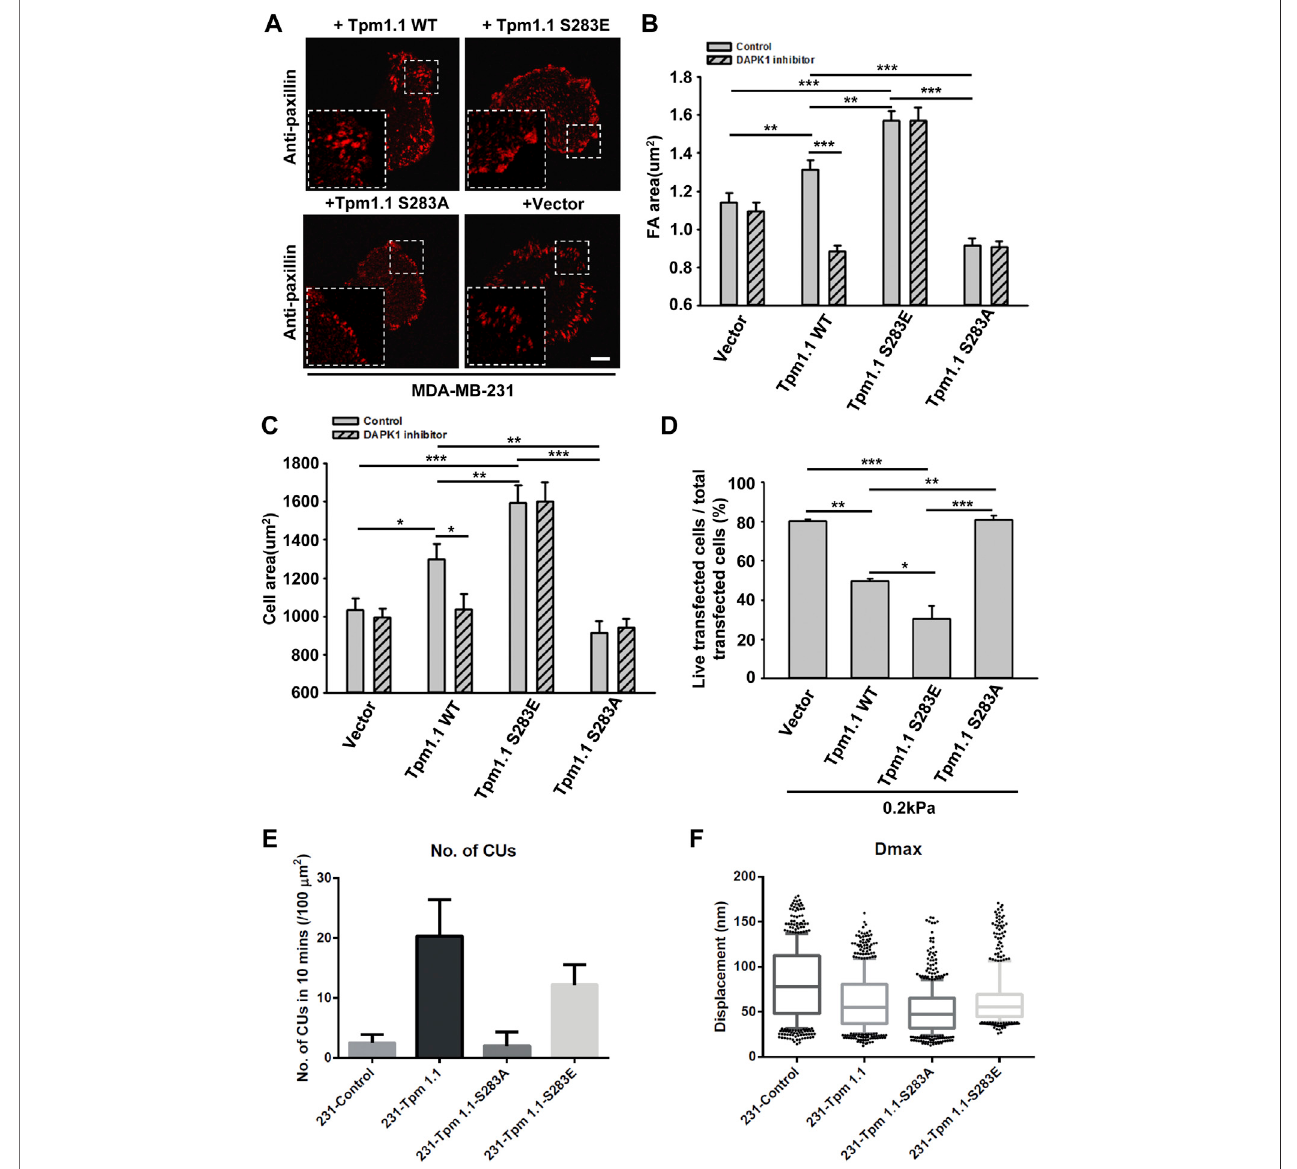
FIGURE 4 | The phosphorylation of Tpm1 by DAPK1 is important for adhesion formation but facilitates anoikis on soft substrates. MDA-MB-231 cells were transfected with Emerald-Tpm1.1 WT, Emerald-Tpm1.1 S283E (phosphomimetic mutant), Emerald-Tpm1.1 S283A (non-phosphorylated mutant), or control vector. Cells were spreading on fi bronectin-coated glass dishes with/without DAPK1 inhibitor for 30 min, followed by anti-paxillin/AlexaFluor 555 immunostaining. (A) Micrographs show the distribution of paxillin. Scale bar: 10 μ m. (B) Quanti fi cation of the adhesion sizes (n > 400 adhesions from > 10 cells in each case, mean ± SEM), ** p < 0.01, *** p < 0.001. (C) Average area ± s.e.m of transfected cells in each group (n > 10 cells in each case). * p < 0.05, ** p < 0.01, *** p < 0.001. (D) MDA-MB- 231 cells were transfected with Emerald-Tpm1.1 WT, Emerald-Tpm1.1 S283E, Emerald-Tpm1.1 S283A or Vector respectively for 1 day and replated on fi bronectin- coated 0.2 kPa gels for 1 day. The percentage of transfected cells that were still alive was quanti fi ed. The mean ± SEM of at least two independent experiments is described. For each experiment, 100 – 150 cells were analyzed for each transfection point. * p < 0.05, ** p < 0.01, *** p < 0.001. (E) Average number of CUs/100 μ m 2 generated by different transfected cells on pillars per 10 min. (F) Box and whiskers plots of pillar maximum displacement summary from different transfected cells.